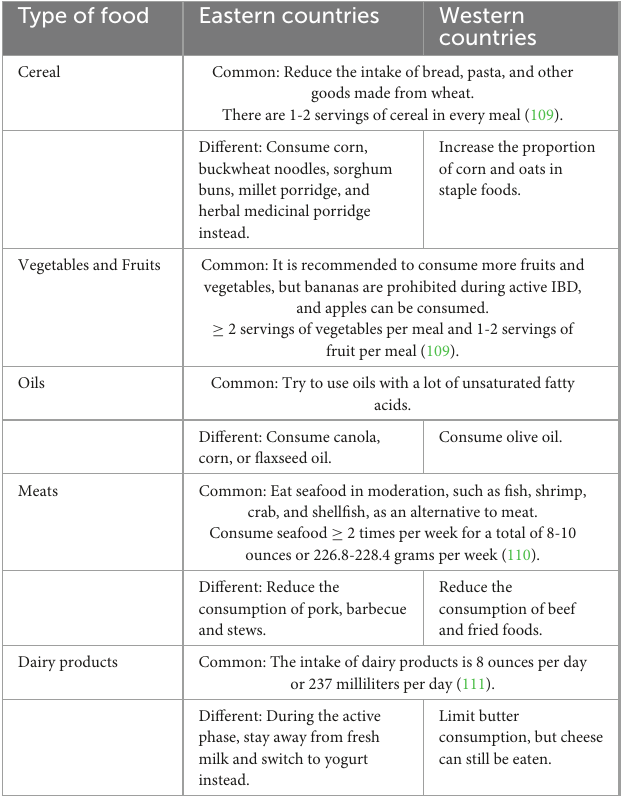
TABLE 5 Dietary recommendations for Eastern and Western countries. Type of food Eastern countries Western